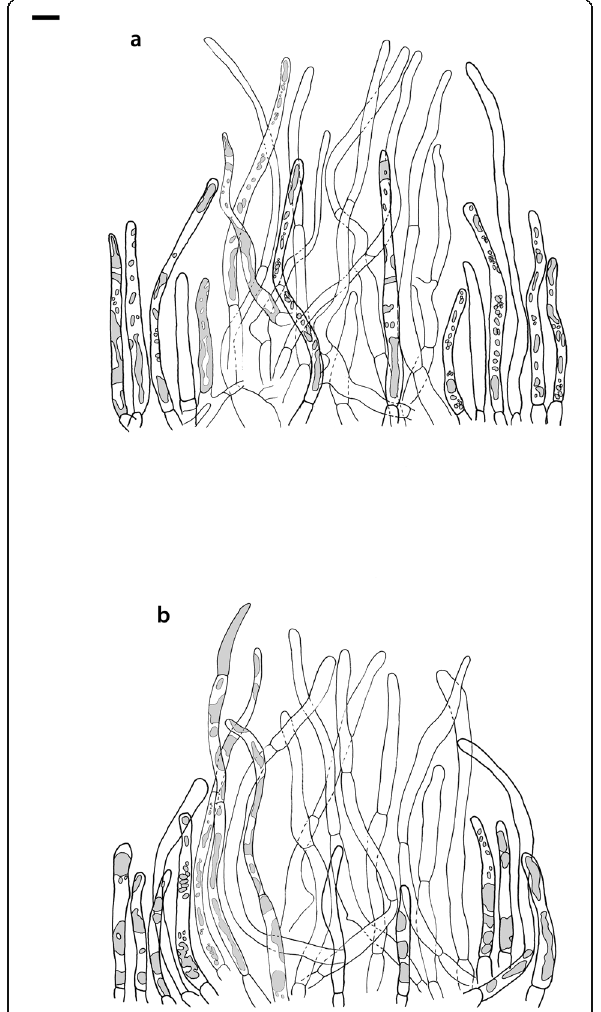
Fig. 9 Russula ambusta (SAV F-3358, FH 2008 ST01), hyphal terminations of the pileipellis. a Near the pileus margin. b Near the pileus centre. Bar = 10 μ m